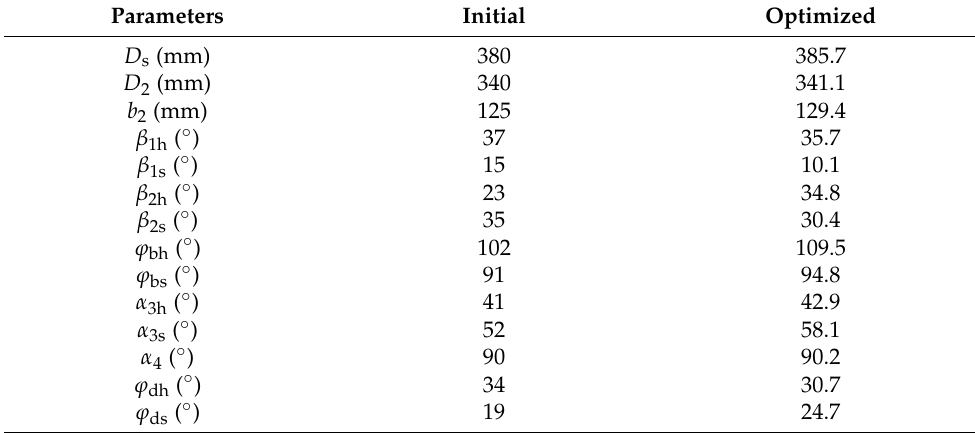
Table 5. Comparison of geometric parameters.